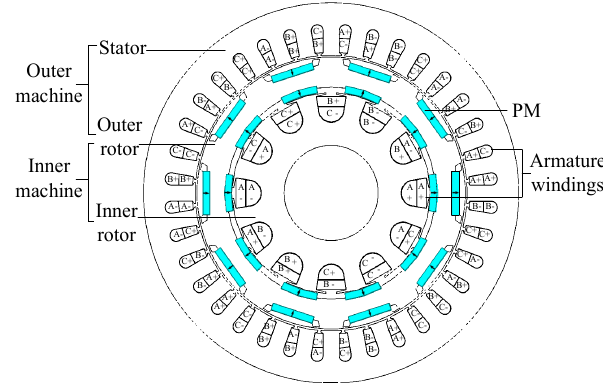
Figure 5. Topology of a conventional DMP machine for the Toyota Prius. Table 2. Size parameters of the CADMP ‐ FSPM machine.